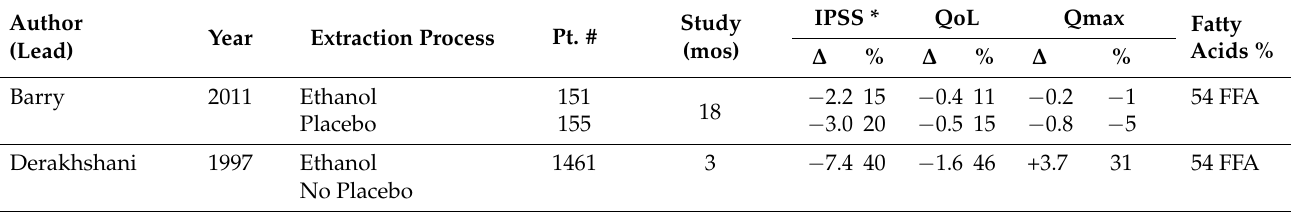
percent; FFA, free fatty acids.